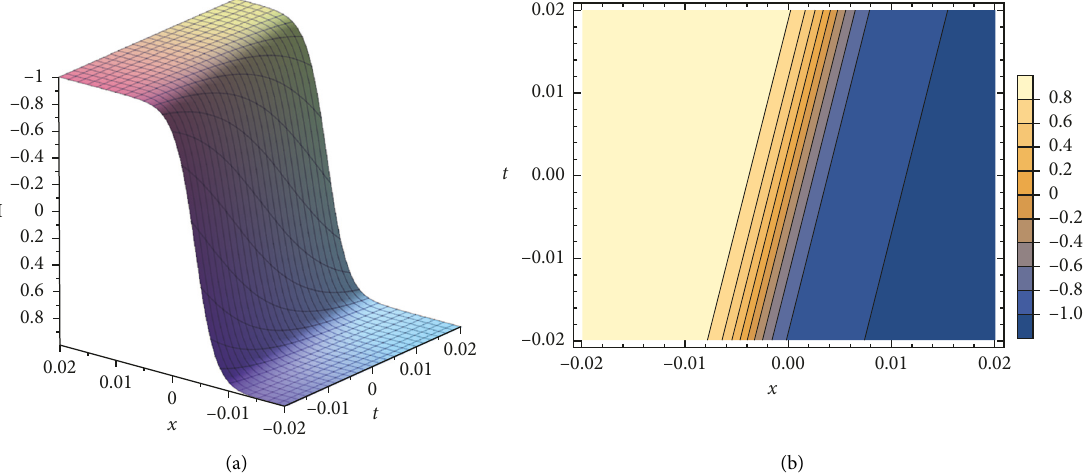
Figure 5: Graphic representation of solution (24) for R 3D graphic and (b) 2D contour